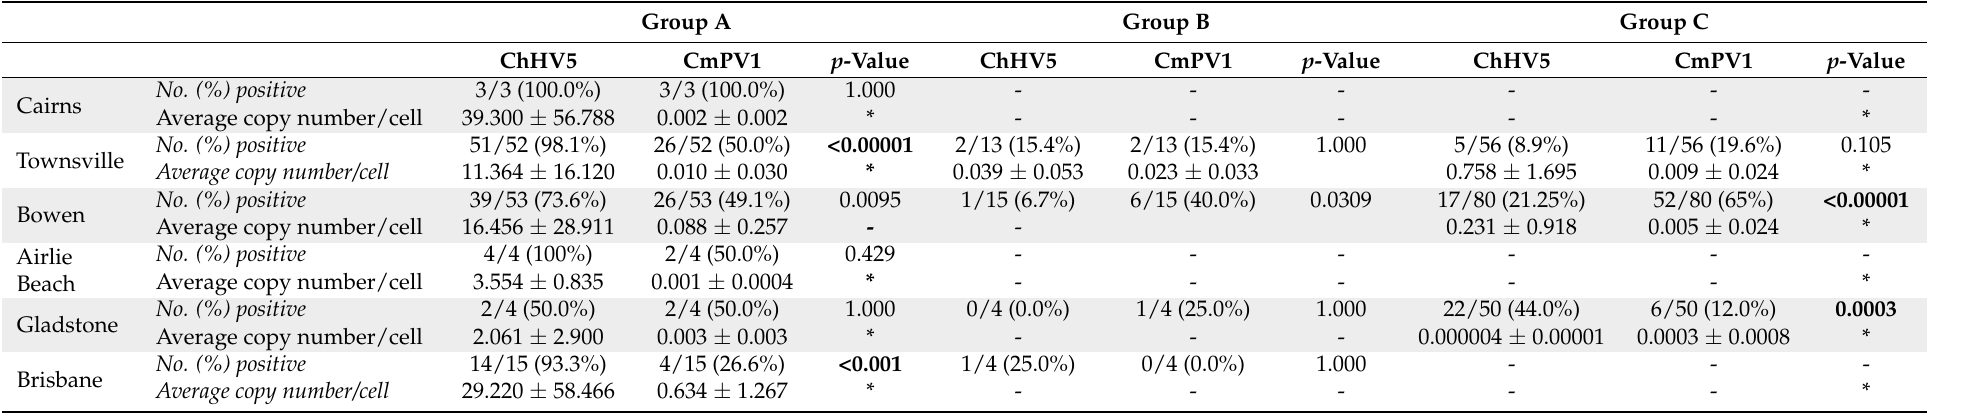
Table 5. Number of viral DNA detections and mean viral load (reported as copy number per cell ± standard deviation) of the samples which tested positive in the three different biological sample types screened in this study; Group A (FP Tumours), Group B (non-tumoured skin from turtles with FP tumours) and Group C (skin from non-tumoured turtles). The number of detections within each group were compared using Chi square and Fisher’s exact test, respectively, with the results also reported here. Statistically significant differences are highlighted in bold. Unavailable samples are denoted by a hyphen. * This is not a meaningful